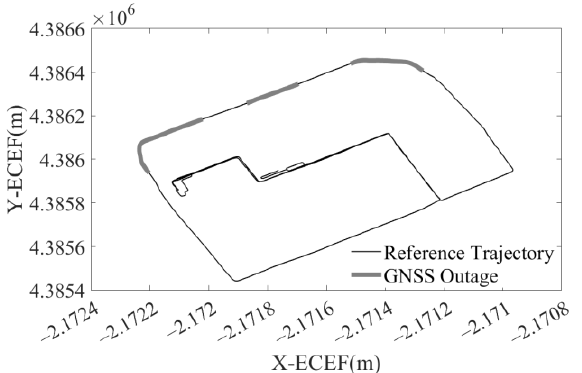
Figure 4. The reference trajectory and three artificial GNSS outages.